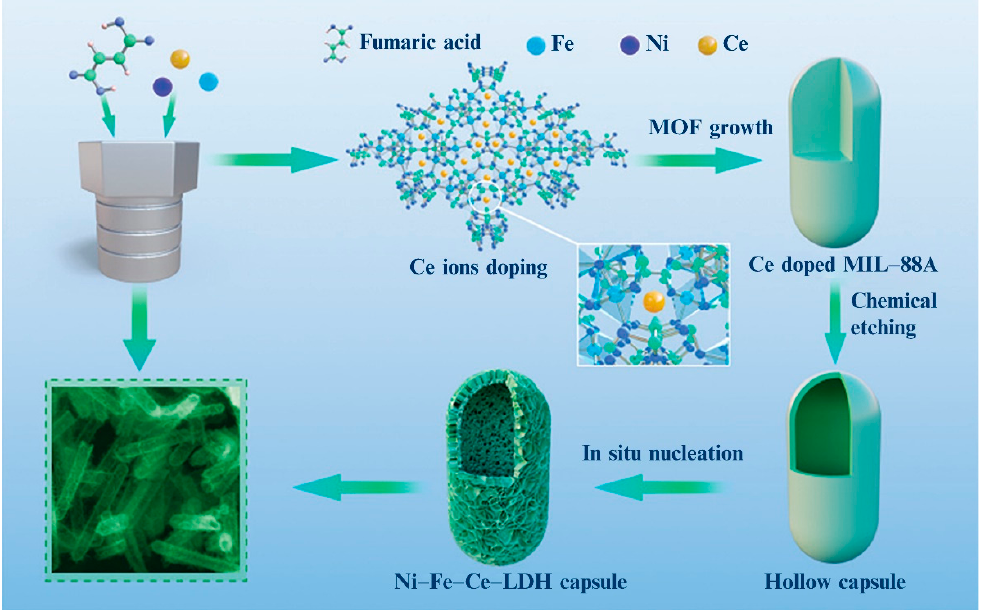
Figure 11. Schematic of the synthesis of hollow Ni–Fe–Ce LDH microcapsules. Reproduced